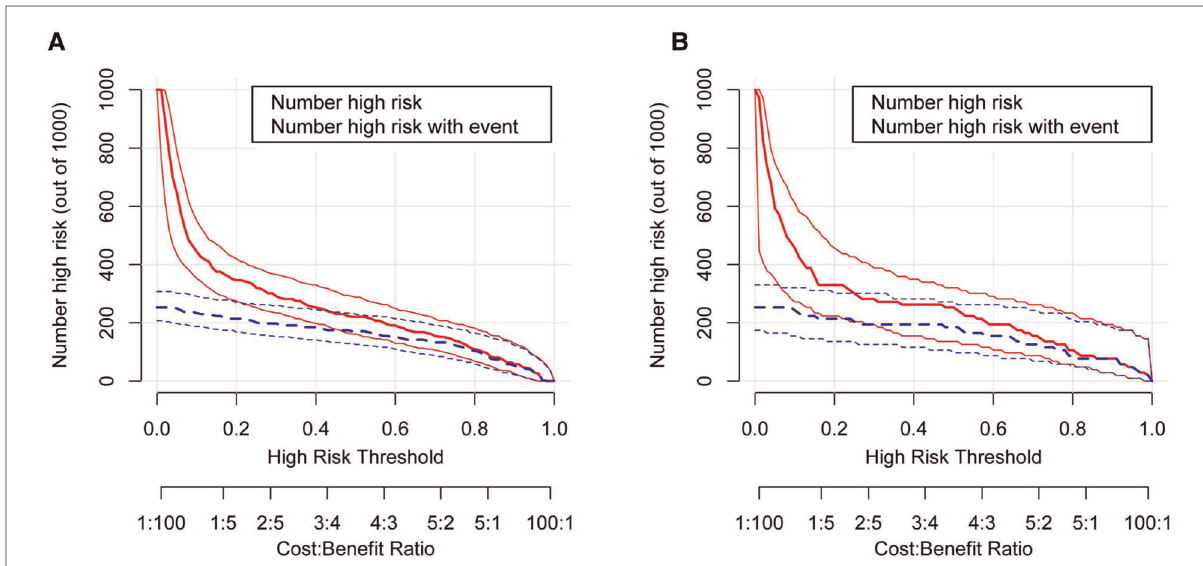
FIGURE 6 The clinical impact curve for the moderate and severe BPD predictive model. Of 1,000 patients, the red solid line shows the total number who would be deemed high risk for each risk threshold. The blue dashed line shows how many of those would be true positives (cases). ( A ) From the training set; ( B ) from the validation set. BPD, bronchopulmonary